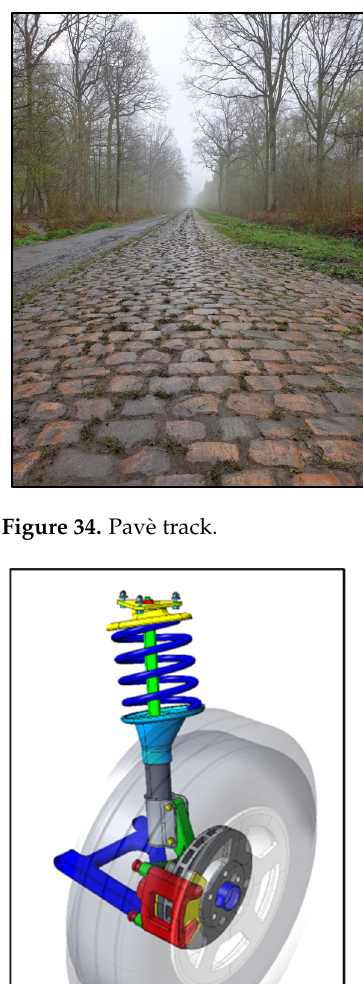
Figure 35. Multibody suspension system.